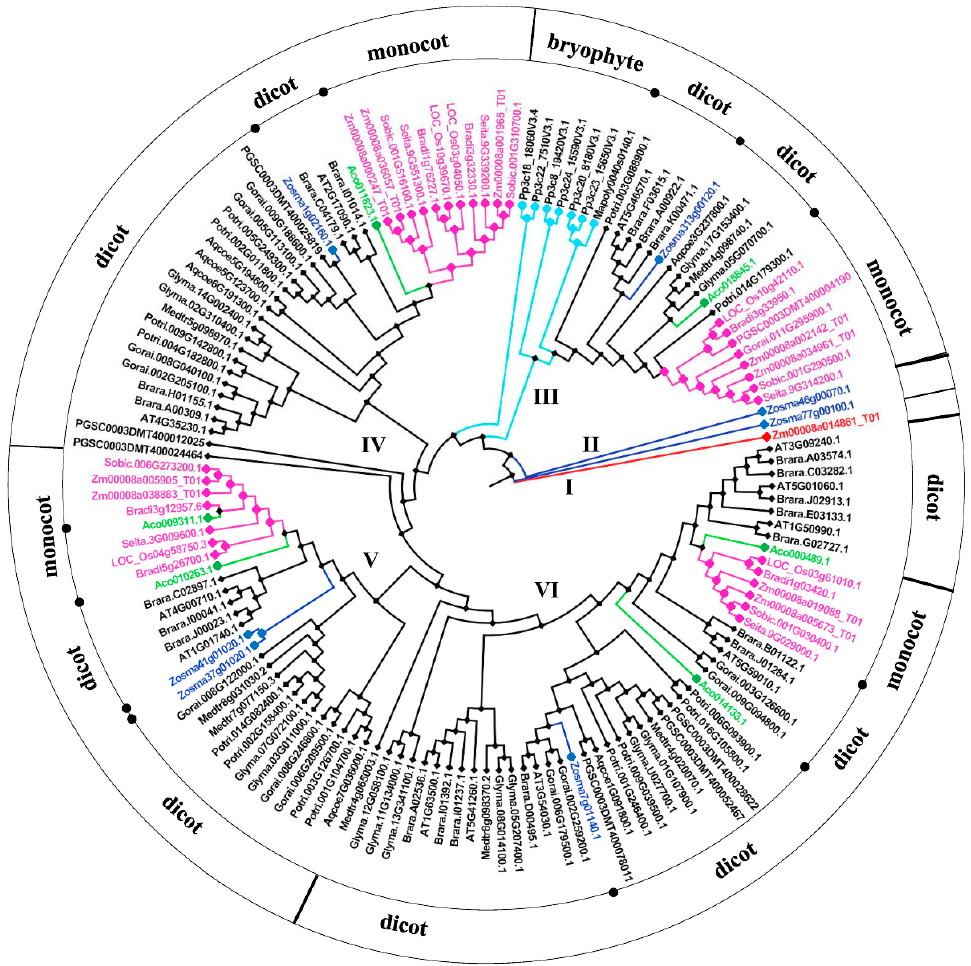
Figure 2. Neighbor-joining phylogenetic analysis of BSK genes. The gene tree was constructed using 143 BSK proteins and visualized using Figure Tree v1.4.2. Representative BSK proteins from different groups were marked with various colors. BSK proteins from dicot plants were in dark, and those from monocot were in pink. Blue and green ones were from Zostera marina and Ananas comosus , respectively.